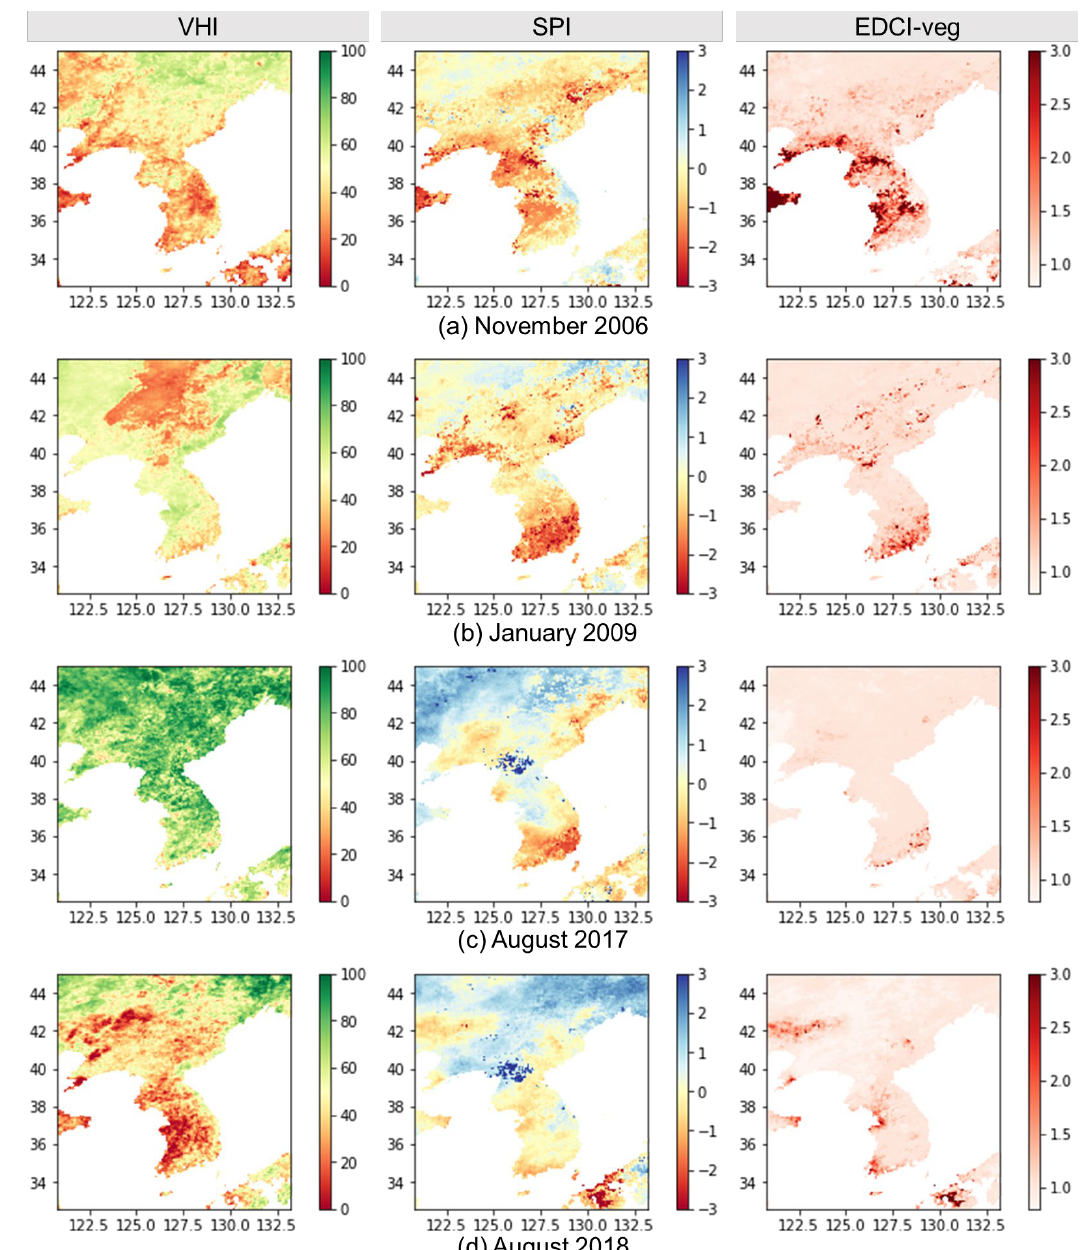
Figure 7. Drought severity map of VHI, SPI and EDCI-veg for ( a ) spring, ( b ) summer, ( c ) fall and ( d ) winter.